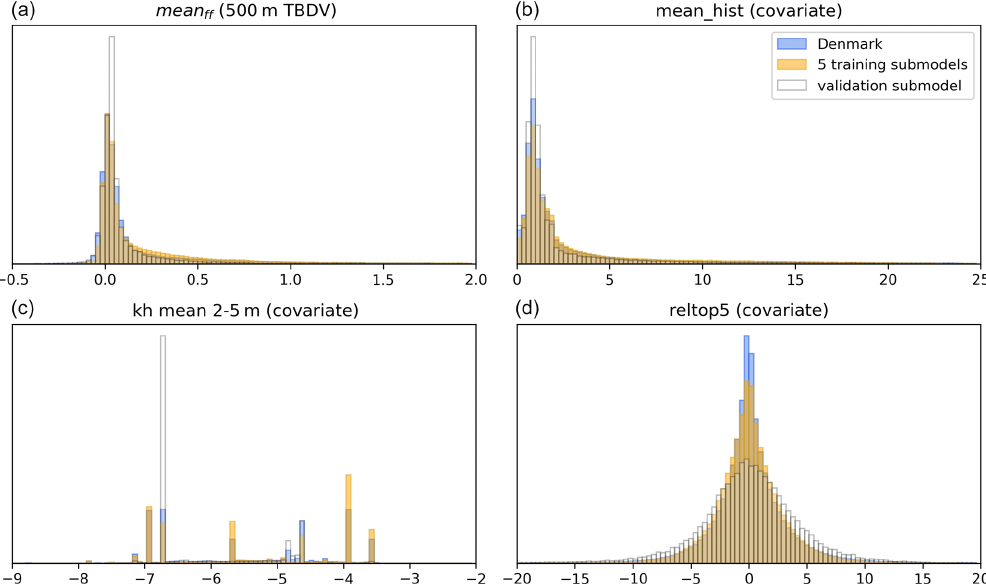
Figure 2. Histograms of covariate ranges covered by the five training and the validation submodels, compared to all of Denmark. Shown for the example of TBDV mean ff . (a) Change in mean depth of shallow groundwater from the 500m model (i.e. the TBDV) [m]. (b) Mean depth of shallow groundwater from the historic 100m model (the respective most important covariate) [m]. (c, d) : kh mean 2–5m ([ms − 1 ], log-transformed) and reltop5 [m] as two more covariates.